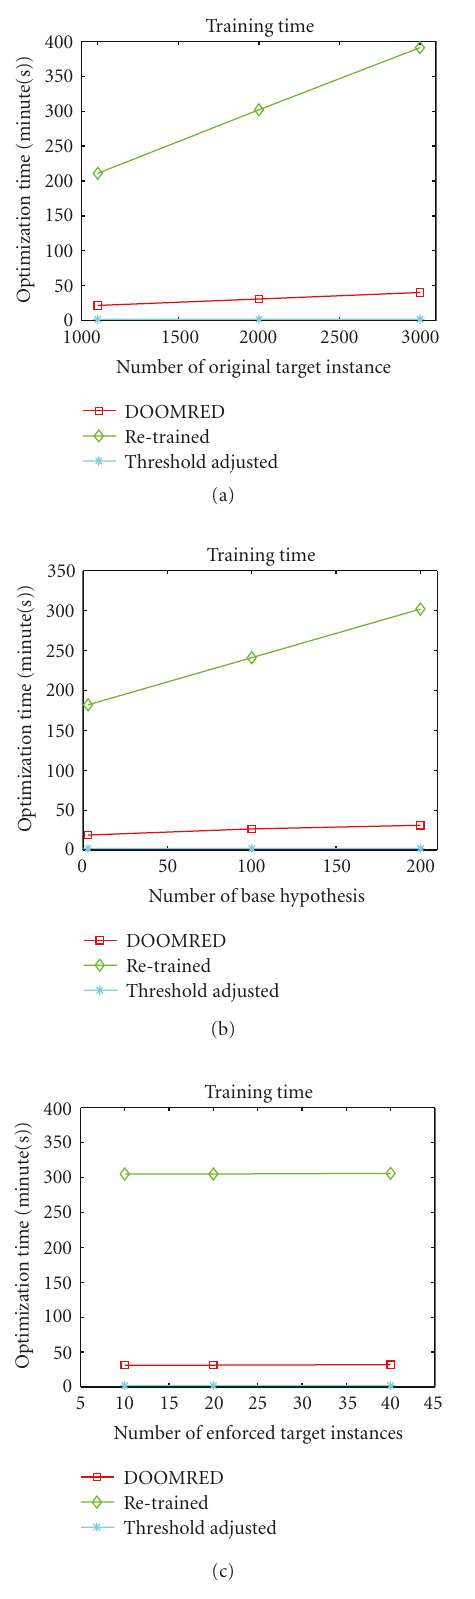
Figure 5: The optimization time for the case in (a) Figure 2, (b) Figure 3, (c) Figure